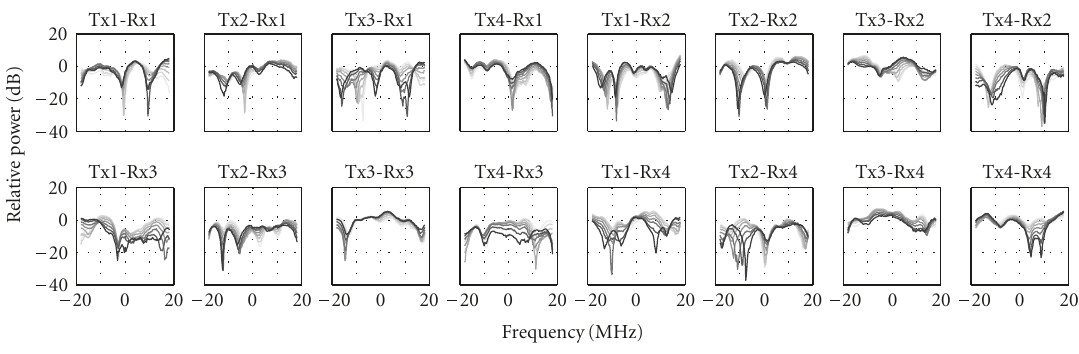
Figure 3: An example of measured MIMO-OFDM frequency response, NLoS 3 (o ffi ce rooms) path.